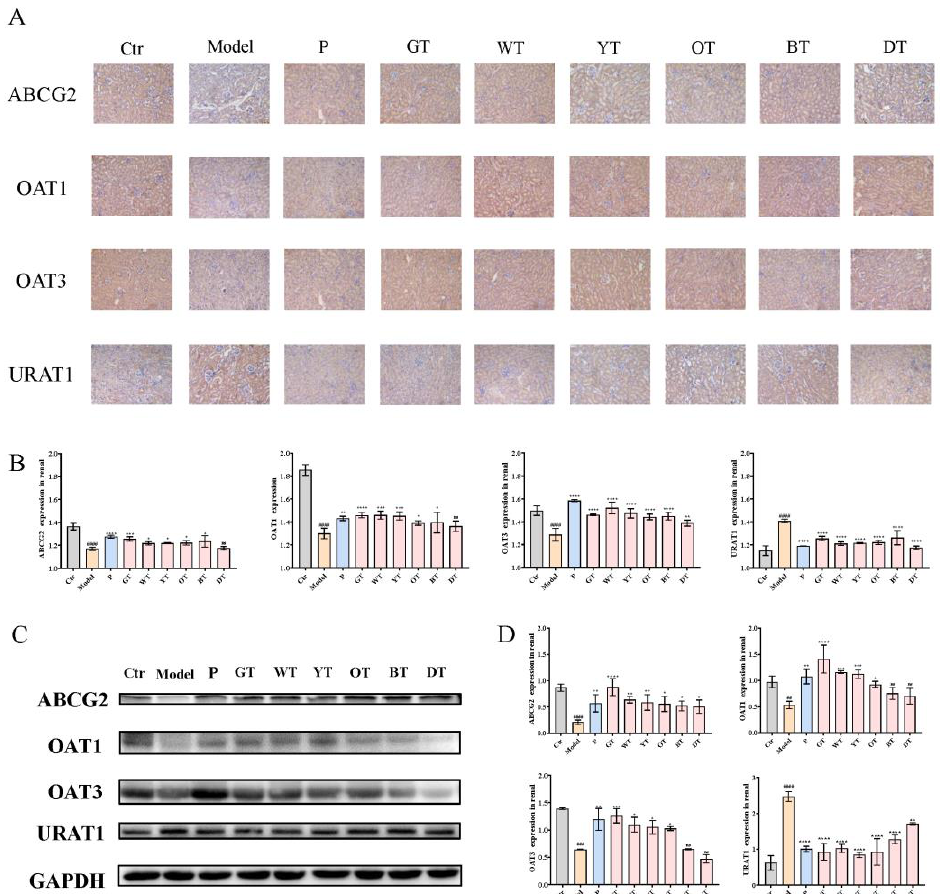
Figure 4. Mechanism of TWEs on UA metabolism in kidney. ( A ) Immunohistochemical staining of uric acid transporters in the kidney (200 × ). ( B ) T bar graphs show the positive rates of ABCG2, OAT1, OAT3, and URAT1 proteins in the kidney. ( C ) Representative immunoblots of ABCG2, OAT1, OAT3, and URAT1 protein expression in the kidney. ( D ) Quantification of ABCG2, OAT1, OAT3, and URAT1 expression levels. The data are expressed as mean ± SD. ## p <0.01, ### p < 0.001, #### p < 0.0001 were compared with the control, ns p > 0.1, * p < 0.1, ** p < 0.01, *** p < 0.001, **** p < 0.0001 were compared with the